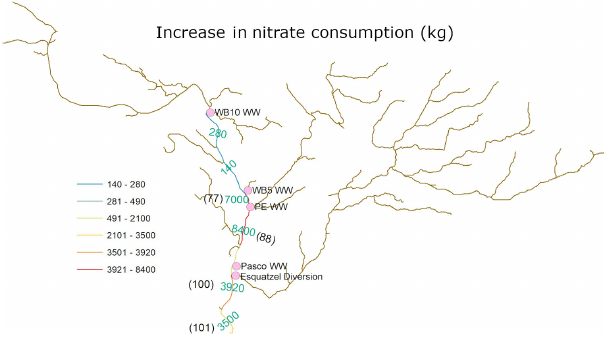
Figure 10. Increase in HZ nitrate consumption (kg) through denitrification due to irrigation return flow compared to case MRMT+BGC. Text in green shows the amount of nitrate consump- tion, pink solid circles are the locations of irrigation wasteways, and numbers in parentheses are reaches of